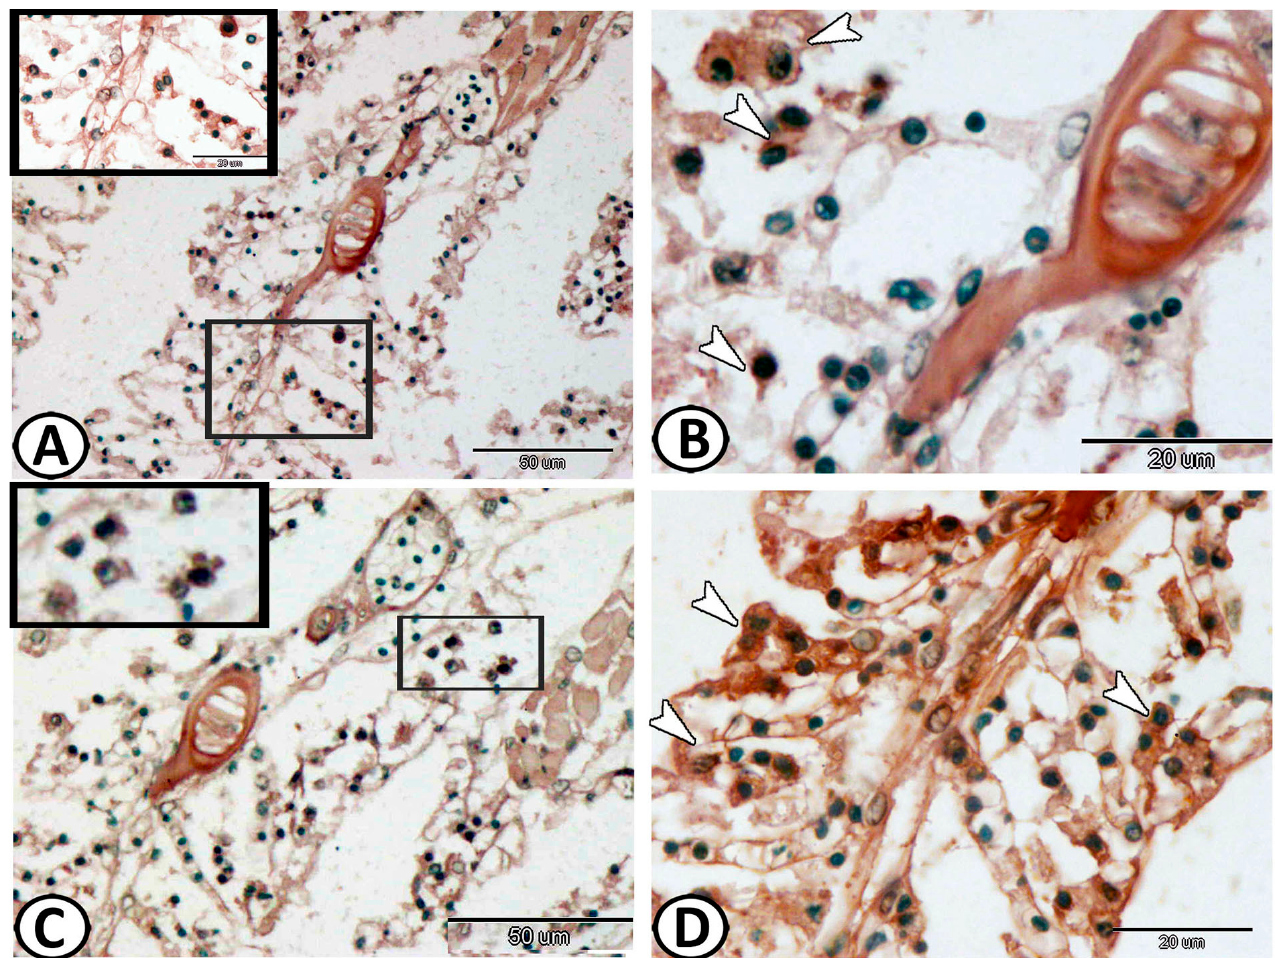
Figure 7. Immunohistochemistry of S100protein. ( A – C ) Neuroendocrine cells expressed S100 protein (arrowheads, boxed areas). ( D ) Chloride cells showed positive immunoreactivity to S100protein (arrowheads).